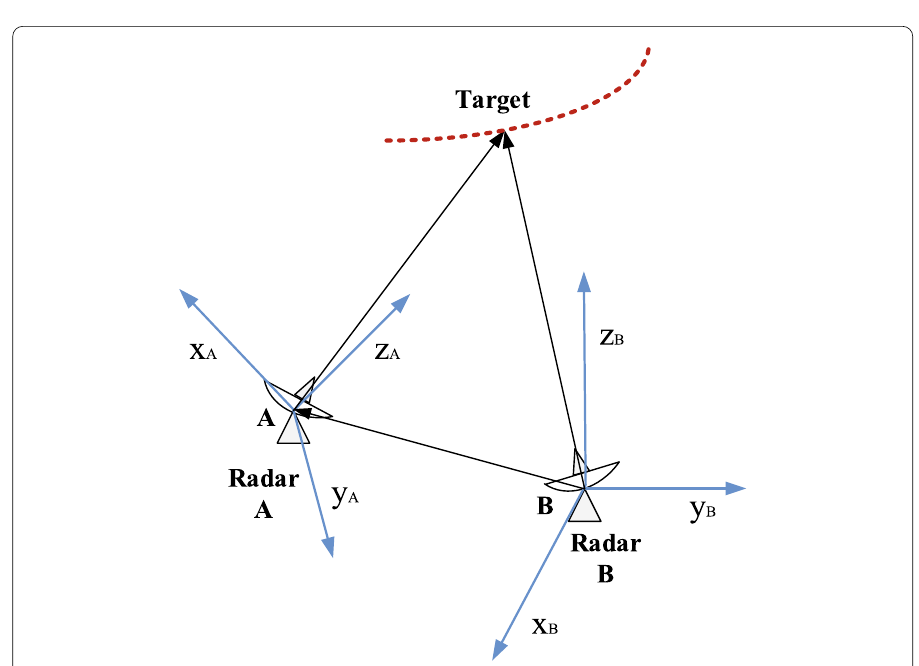
Fig. 3 The alignment model for networked